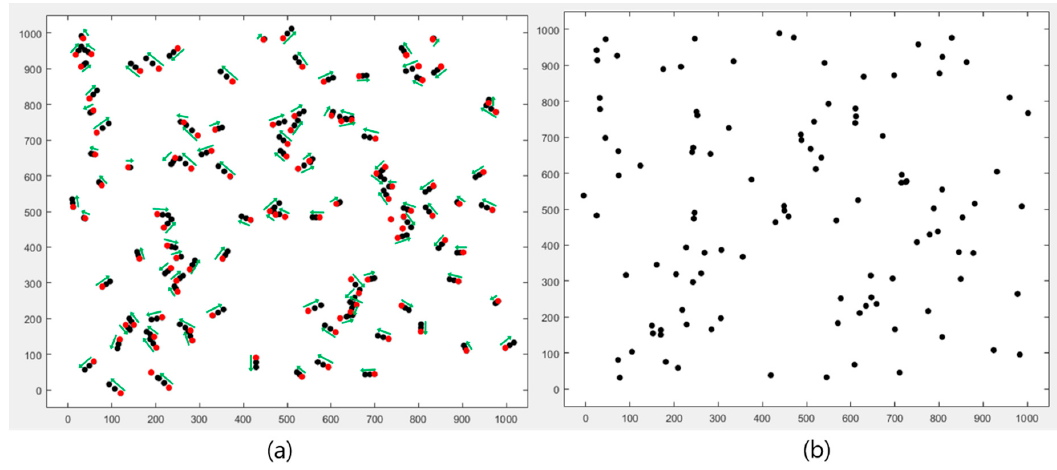
Figure 8. The node location ( a ) dynamic topology model, ( b ) static topology model.